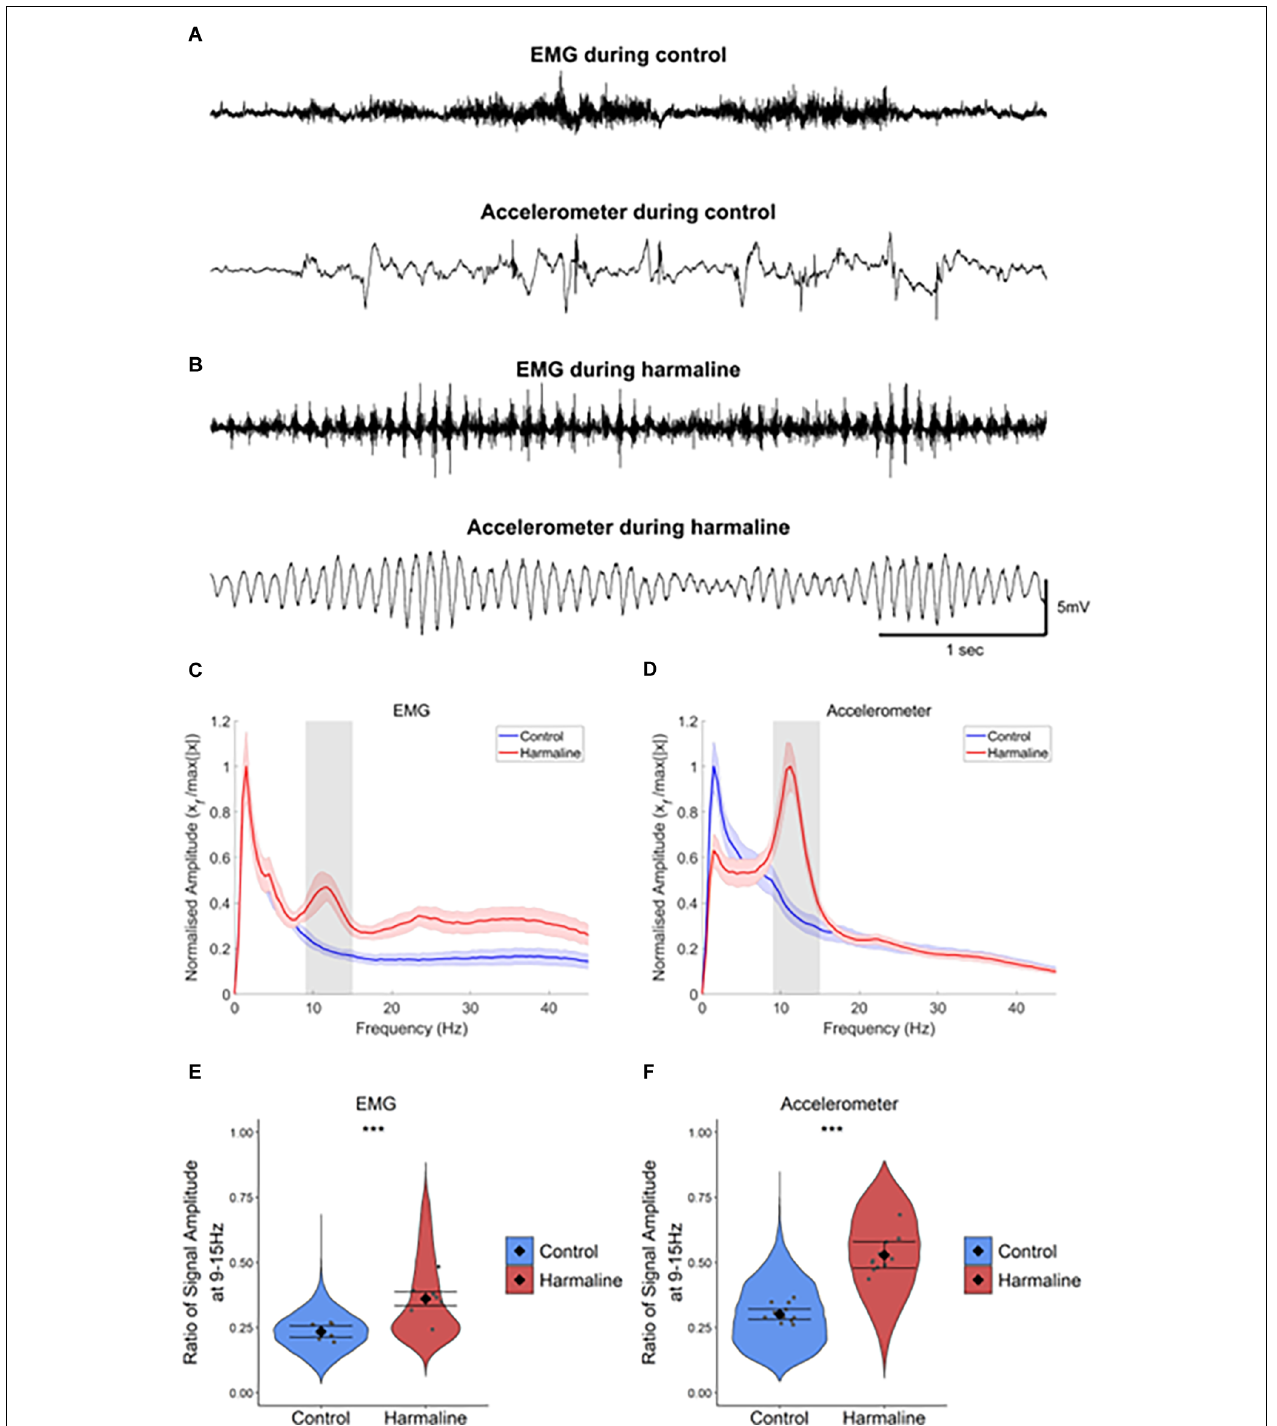
FIGURE 1 | Harmaline induces a 9–15 Hz tremor. (A,B) Representative example EMG and accelerometer recording from a rat during (A) control and (B) harmaline. The upper trace is EMG, and the lower trace is accelerometer. (C,D) Mean ( ± SE) amplitude spectrum for (C) EMG ( n = 7 rats) and (D) accelerometer ( n = 12 rats) during control and harmaline. The solid line represents mean amplitude, and the coloured shaded areas represent SE. The grey area represents the tremor frequency (9–15 Hz). (E,F) Ratio of amplitude at the tremor peak for (E) EMG and (F) accelerometer, where the violin plots show the distribution of this ratio across all epochs (pooled across rats). Individual grey data points represent the mean per rat. Fixed effects parameter estimates ( ± CI) representing predicted mean estimates are shown by (cid:7) and corresponding error bars. ∗∗∗ indicates p < 0.001.